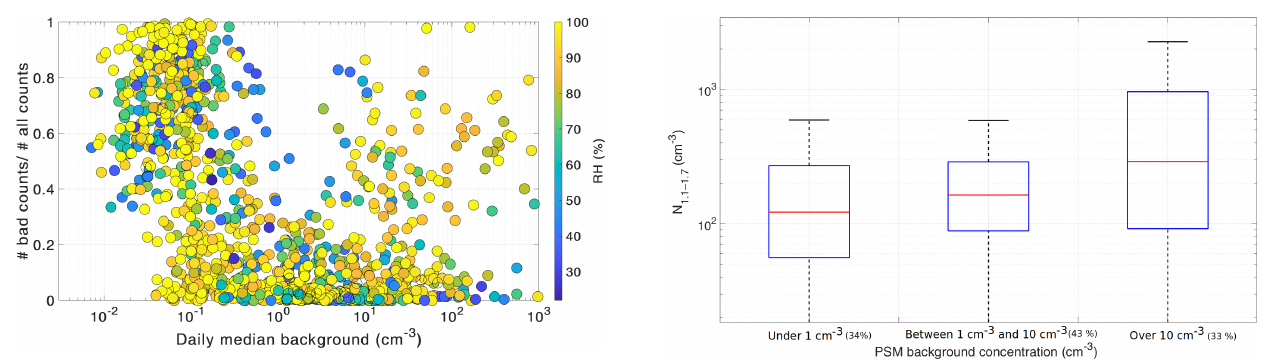
Figure 2. Box plots of the measured 1.1–1.7nm particle concentra- tion at SMEAR II grouped with the PSM background concentration. The red line is the median concentration, and the blue box contains 50% (25th to 75th percentile) of all data points. The whiskers mark the location of the 95th and 5th percentile data points. The number in parentheses indicates the fraction of all data points in each